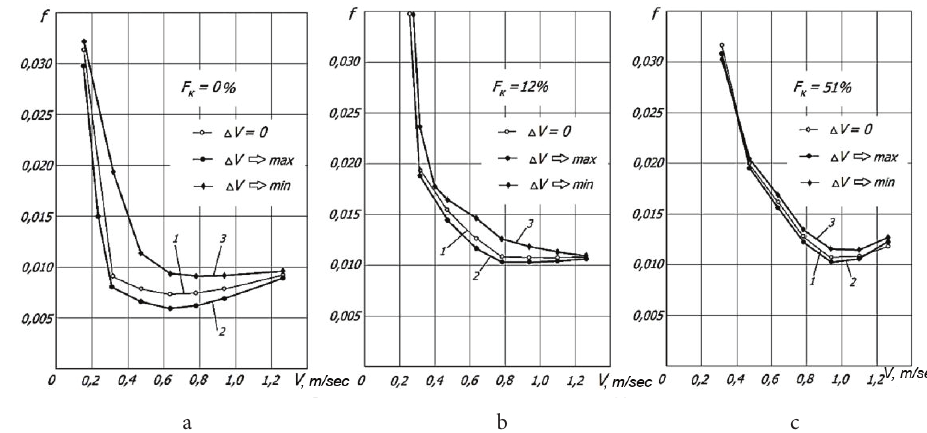
Figure 12. Dependence of the friction coefficient f on the velocity V: 1 − under the steady-state friction regime ( Δ V = 0); 2 − with a smooth increase in the sliding velocity V ; 3 − with a smooth decrease in the speed V. T he relative area of microgrooves F k : A − F k = 0%; B − F k = 12%; В − F k =